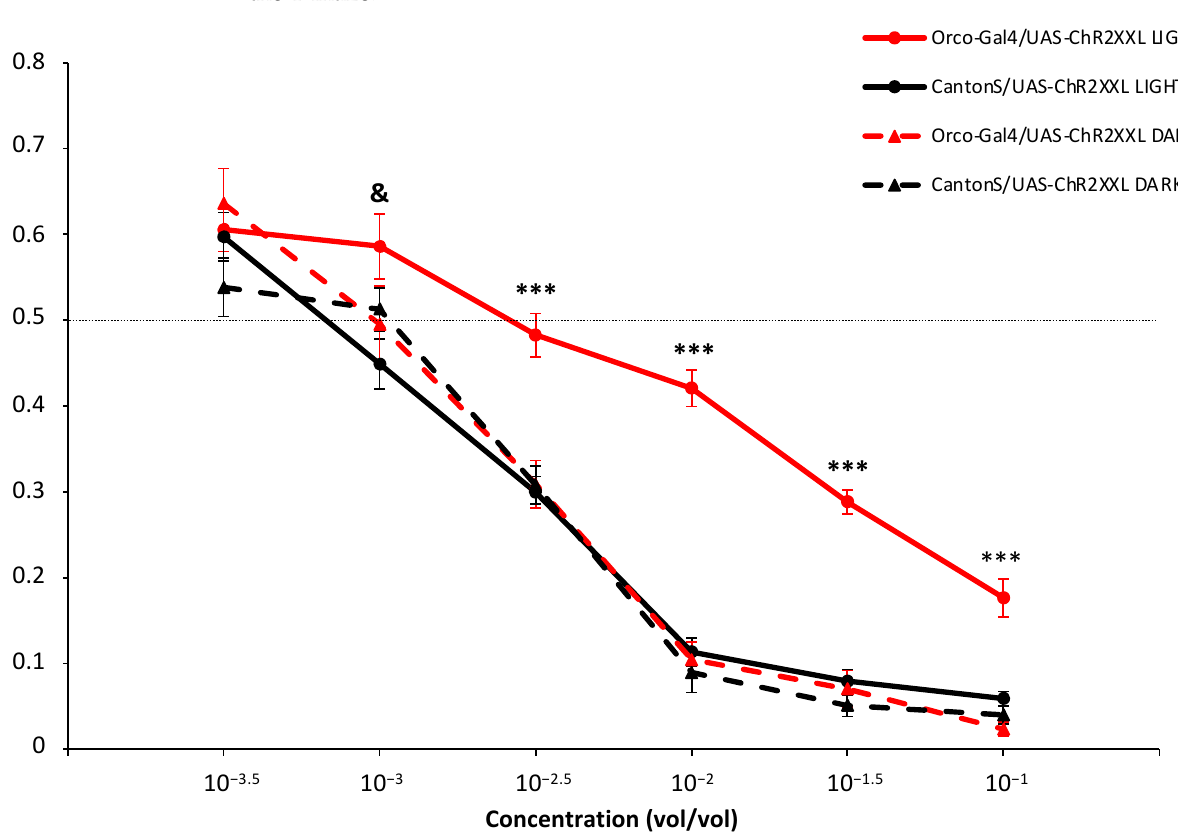
Figure 4. Olfactory behavior with optogenetic activation of Orco-expressing Olfactory Sensory Neurons (OSNs). Dose–response curve of olfactory responses to ethyl acetate in four fly genotypes. Each point shows the average Olfactory Index (IO) ± SEM for each concentration, genotype and light condition. At the 10 − 3 concentration, only differences between Orco-Gal4/UAS-Chr2XXL LIGHT and CantonS/UAS-ChR2XXL LIGHT became statistically significant (& = p < 0.05). For the 10 − 2.5 to 10 − 1 concentrations, highly significant differences (*** = p < 0.001) appeared between Orco-Gal4/UAS-Chr2XXL LIGHT and the other 3 classes, which were equal to each other.